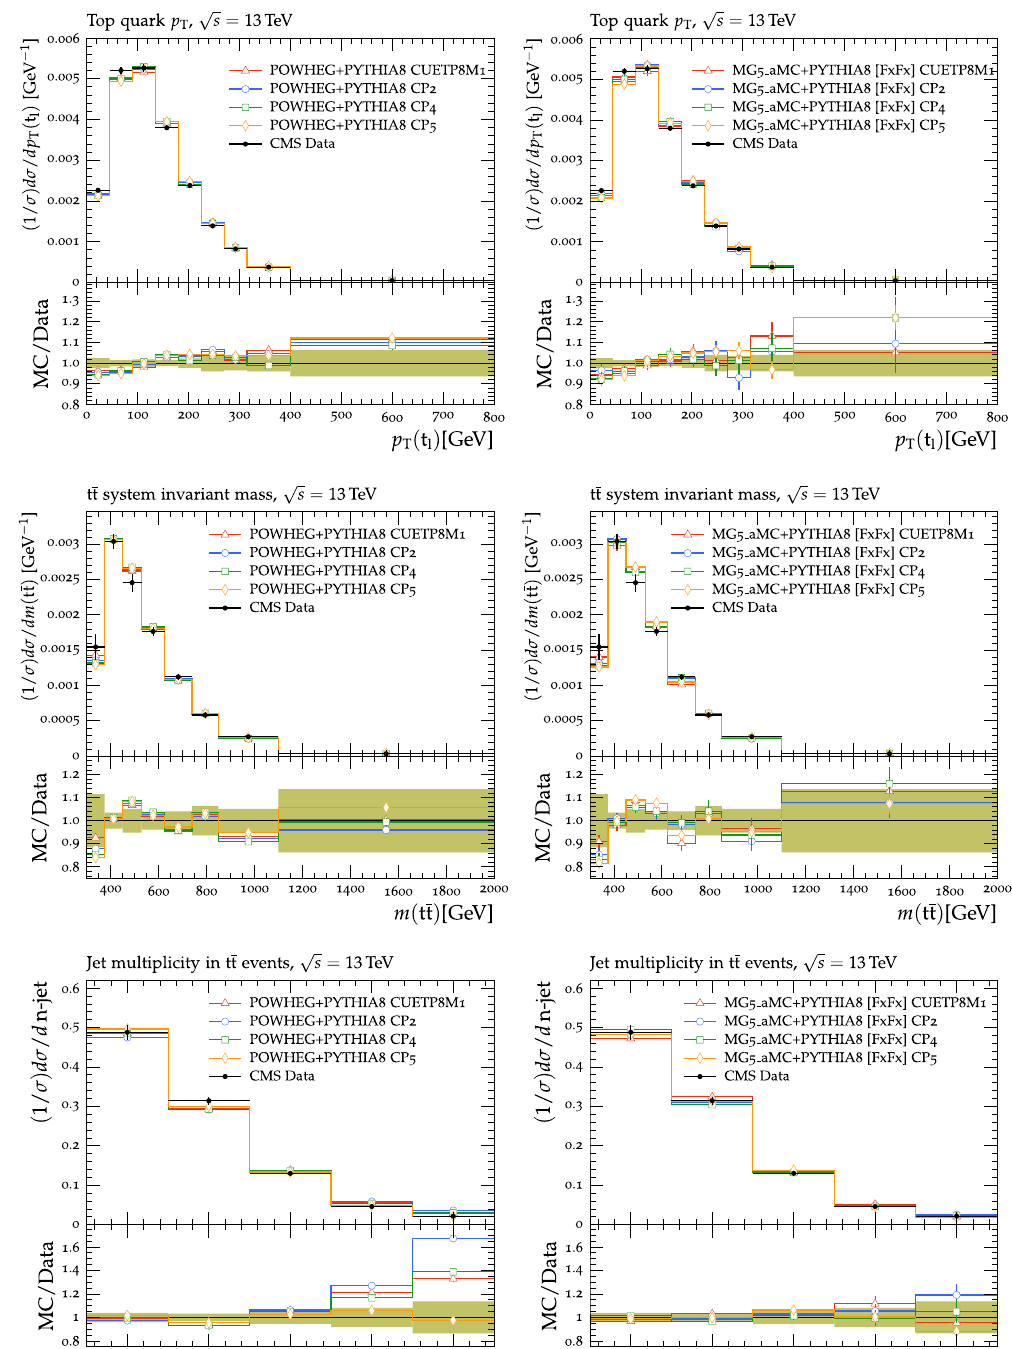
Fig. 19 The normalized tt cross section in the lepton + jets channel, as a function of the transverse momentum of the top quark for leptonically decaying top quarks ( t (cid:10) ) (upper), the invariant mass of the tt system, m (tt) (middle), and in bins of number of additional jets (lower) from √ s = 13TeV analysis [69]. The data are compared with the pre- CMS dictions of powheg (left) and mg5 _a mc [FxFx] (right). In both cases, the PS simulation is done with the pythia 8 tunes CUETP8M1, CP2,